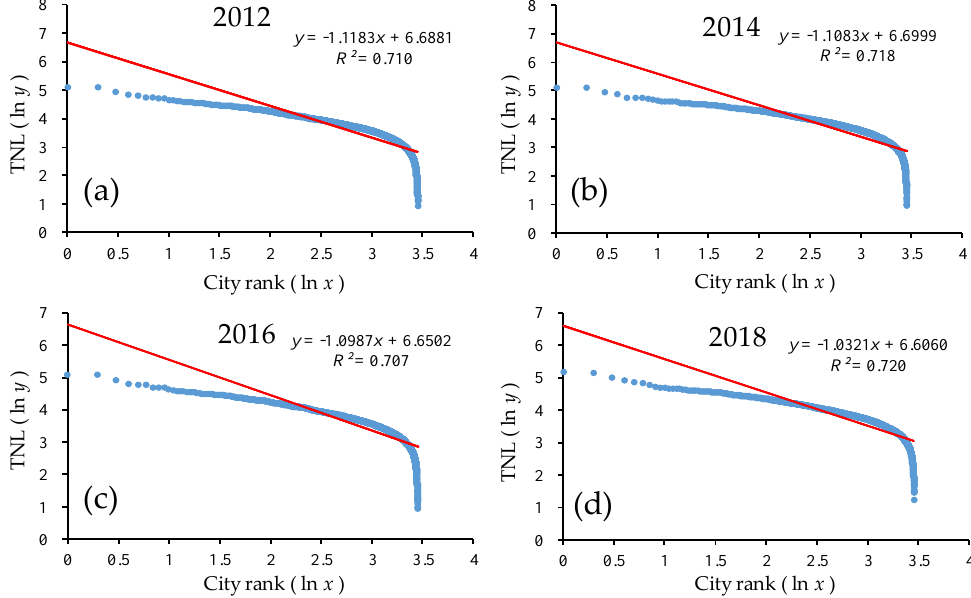
Figure 11. The ln-ln plot of the rank–size of the urban development for all counties. Line regression of (a) TNL and ranking of all counties in 2012; (b) TNL and ranking of all counties in 2014; (c) TNL and ranking of all counties in 2016; (d) TNL and ranking of all counties in 2018.